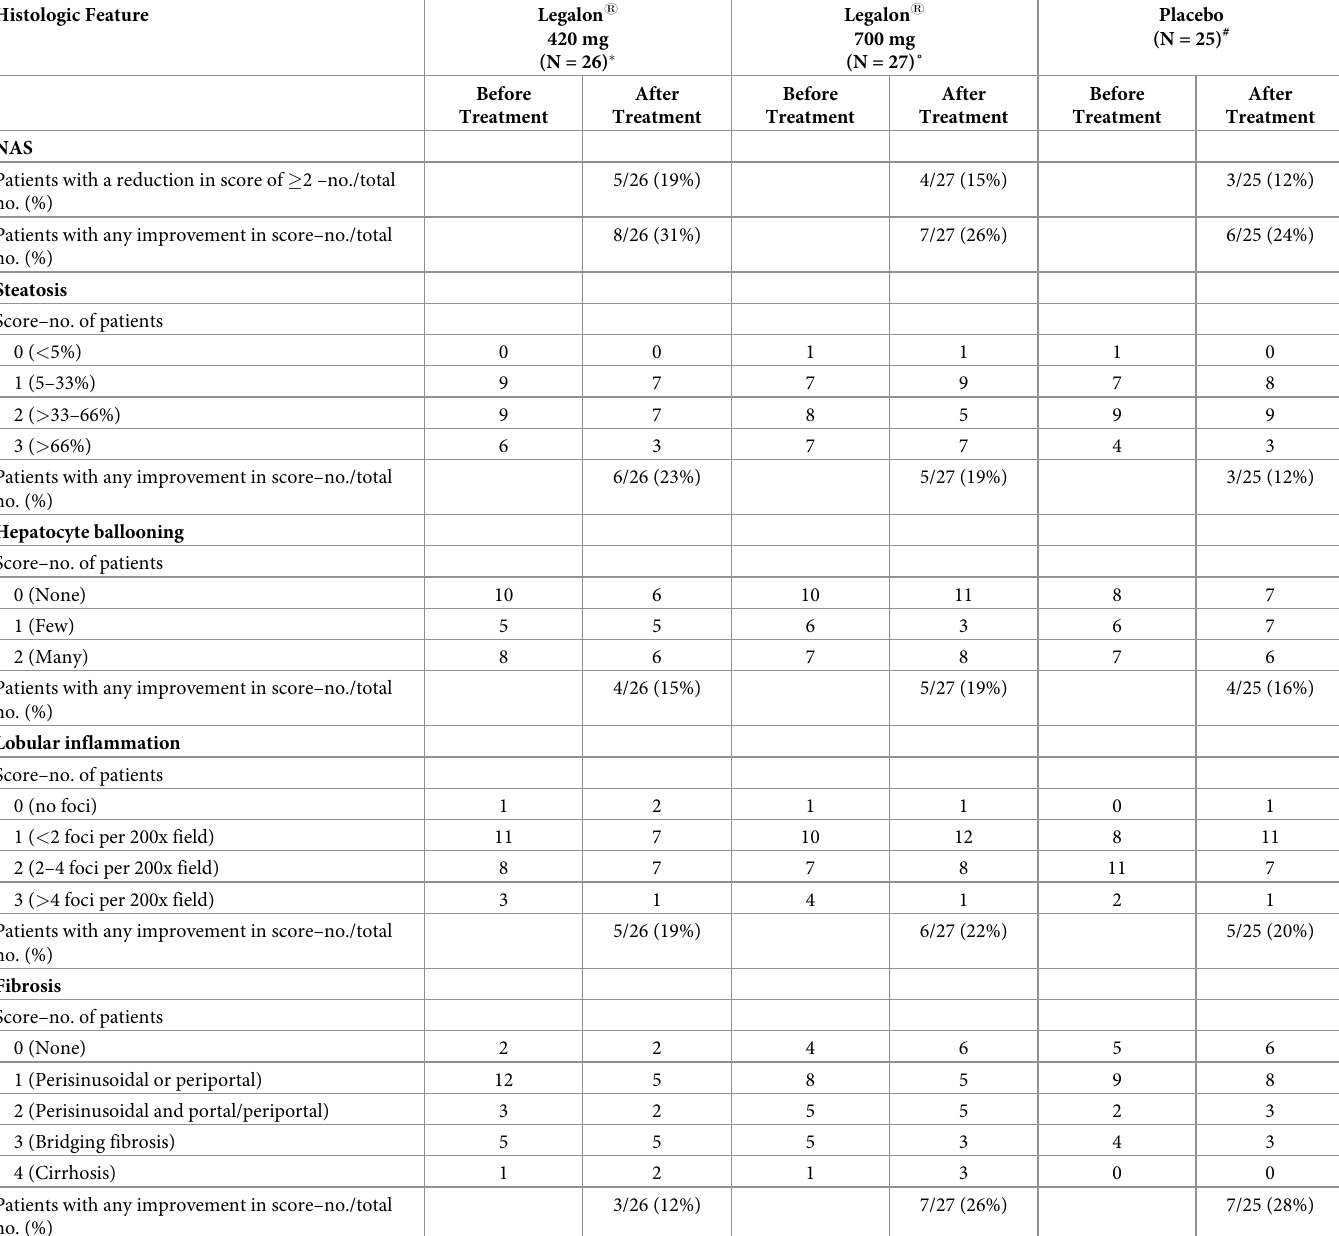
Table 3. Hepatic histologic scores. Intention to Treat